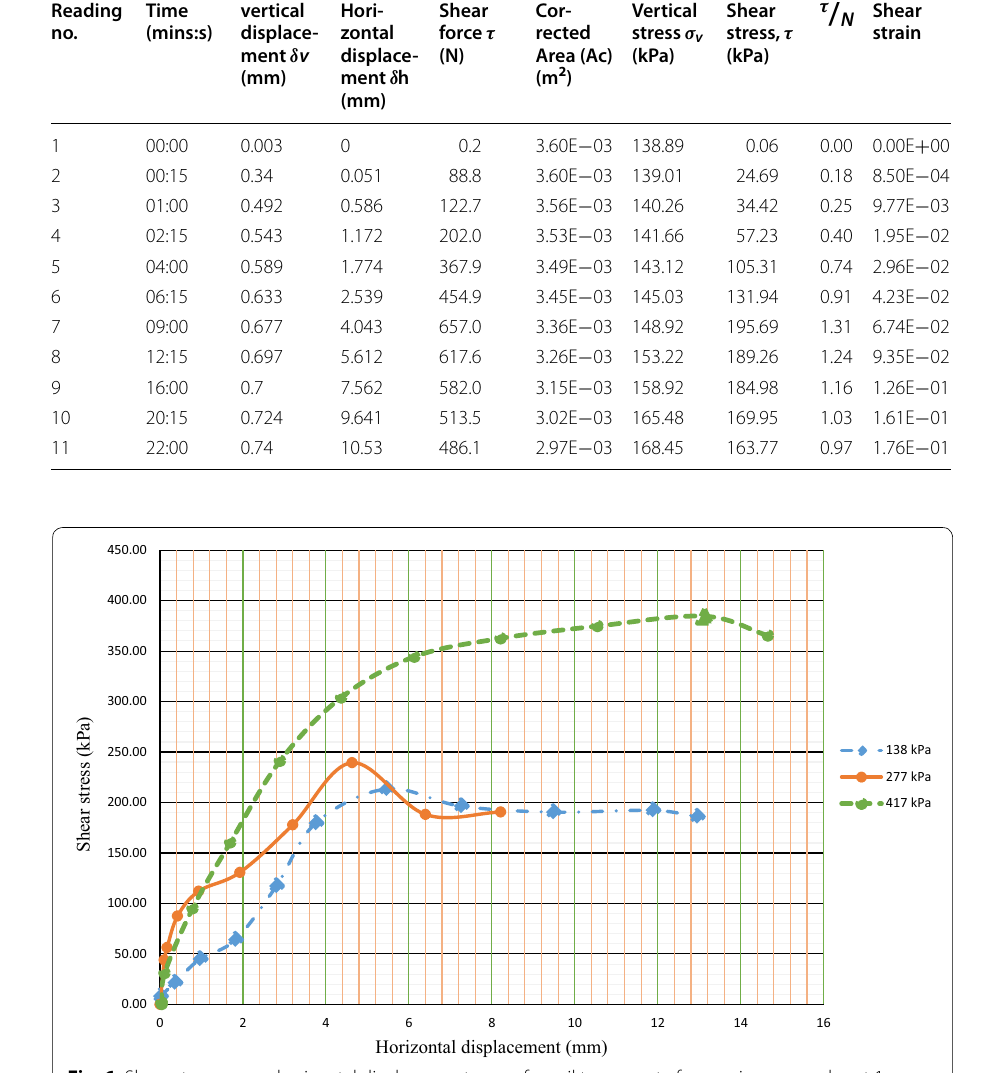
Fig. 6 Shear stress versus horizontal displacement curve for soil to concrete for specimen sample set